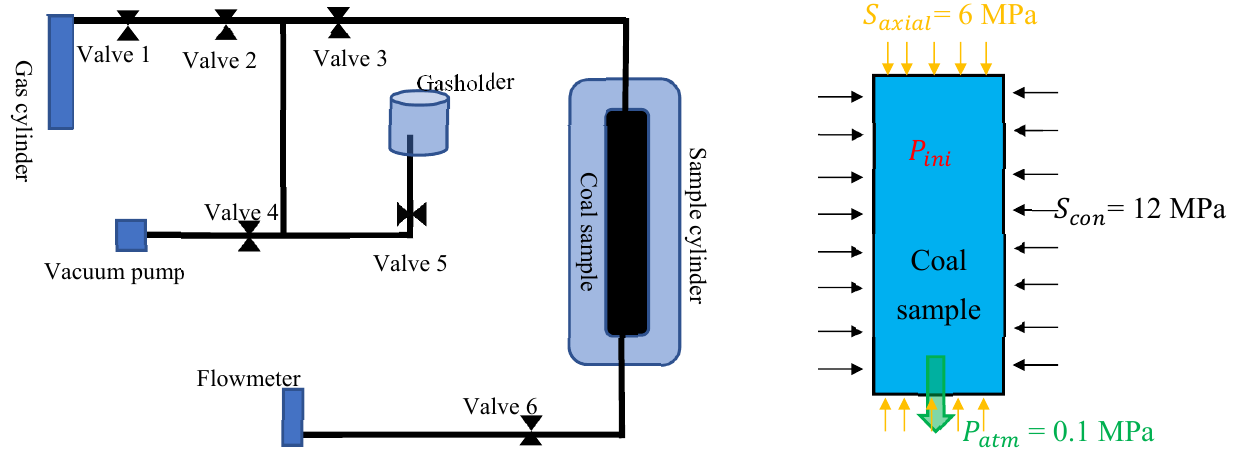
Figure 2. Experimental platform structure and Experimental set-up.